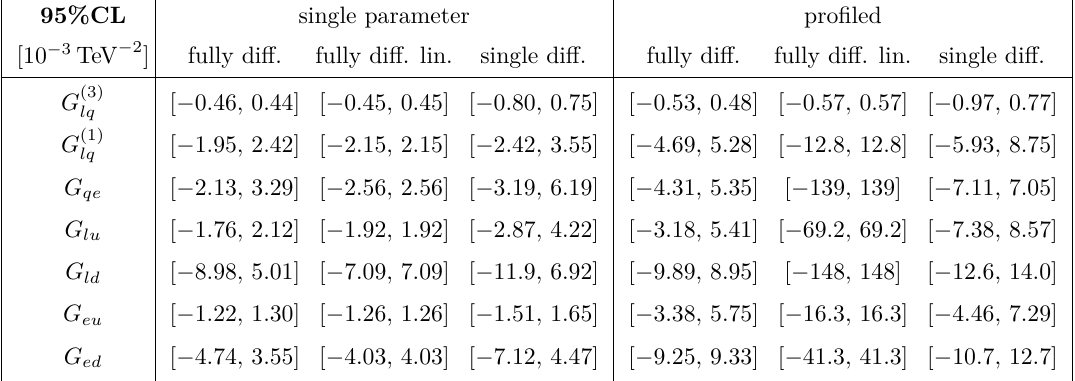
Table 3 . 95% CL projected bounds for the four-fermion operator coefficients in the Warsaw basis. The bounds are given in 10 − 3 TeV − 2